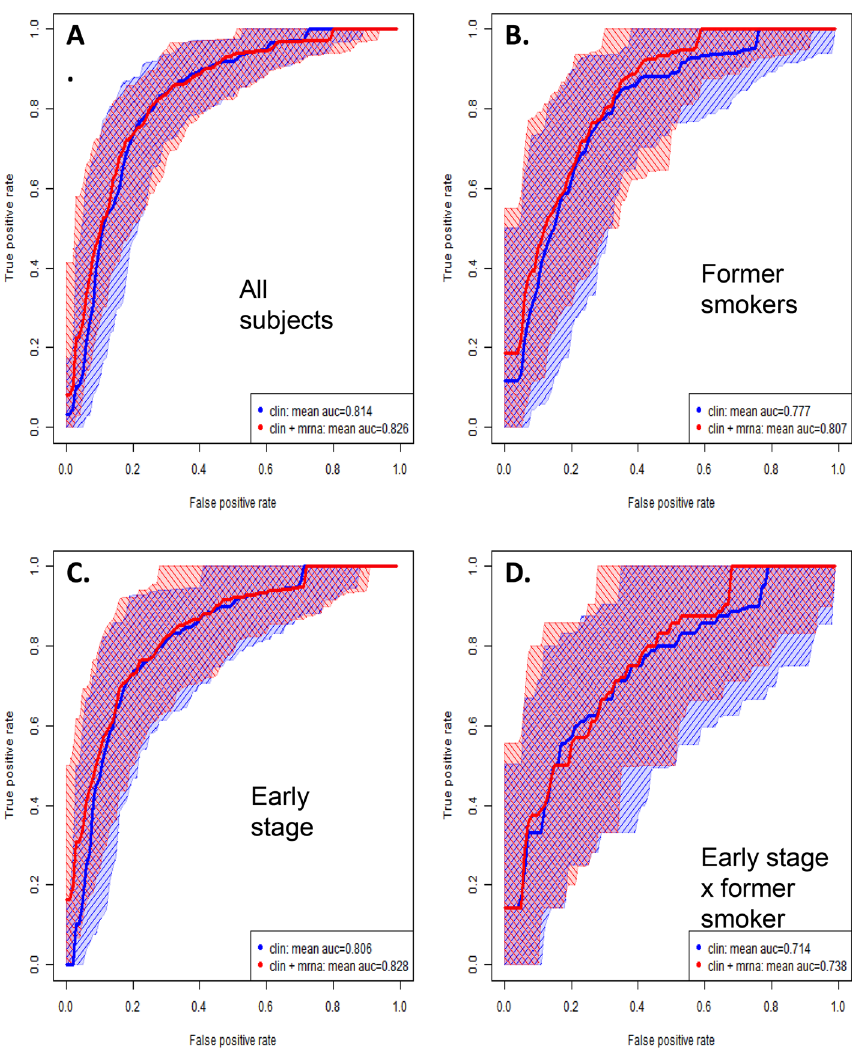
Figure 3. Receiver Operating Curves (ROC). Compare clinical factors alone model versus clinical factors + exhaled microRNAs combined model (red), to distinguish early stage (I + II) lung cancer all tumor histologies case donors combined, versus non-cancer controls. ( A ) All smoking categories combined; ( B ), Former smokers only; ( C ) Early stage only; ( D ) Early stage x former smokers. Random forests, recursive partitioning and cross-validation were employed as described in the statistical analysis section. This ROC plot of true positives versus false positives shows borderline incremental information (Fig. 3A, Clinical AUC + 1.2% ( p = 0.07)) value of the exhaled microRNAs over and above the clinical model alone, in all subjects combining all smoking status’, stages, and histologies. It particularly held true in main subgroup analyses, separating out former smokers (Fig. 3B, Clinical AUC + 3.0% ( p = 6.0e−03)), and in early stage (I,II) models (Fig. 3C, Clinical AUC + 2.2% (5.1e−03)). In combining these subgroups ( D ), early stage x former smokers combined did not show significant case–control discrimination (Fig. 3D, NS). Model components and significance testing of area under curve (AUC) differences are described in Table